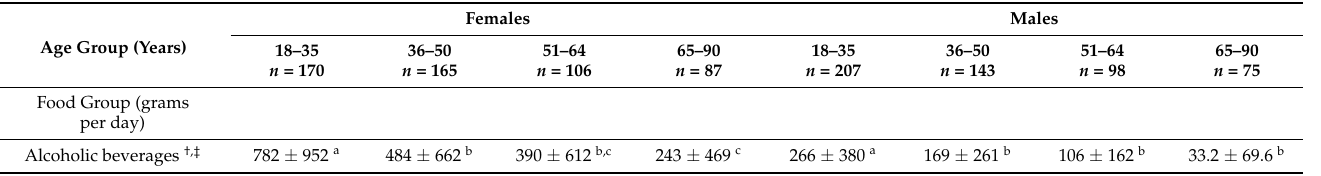
Table 3. Food group intakes by age group and